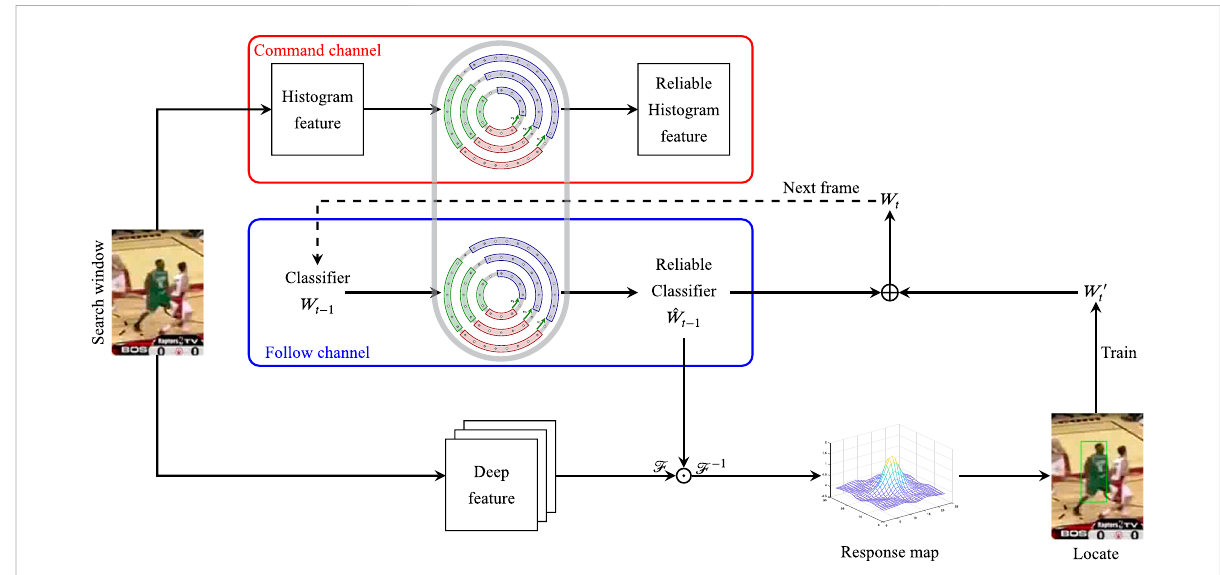
FIGURE 3 Pipeline of the MRM-based CF Tracker, the MRM model in the command channel gets the memory information update rule, and the follow channel updates the classi fi er in the CF tracker according to the rule, thereby improving the performance of the classi fi er.